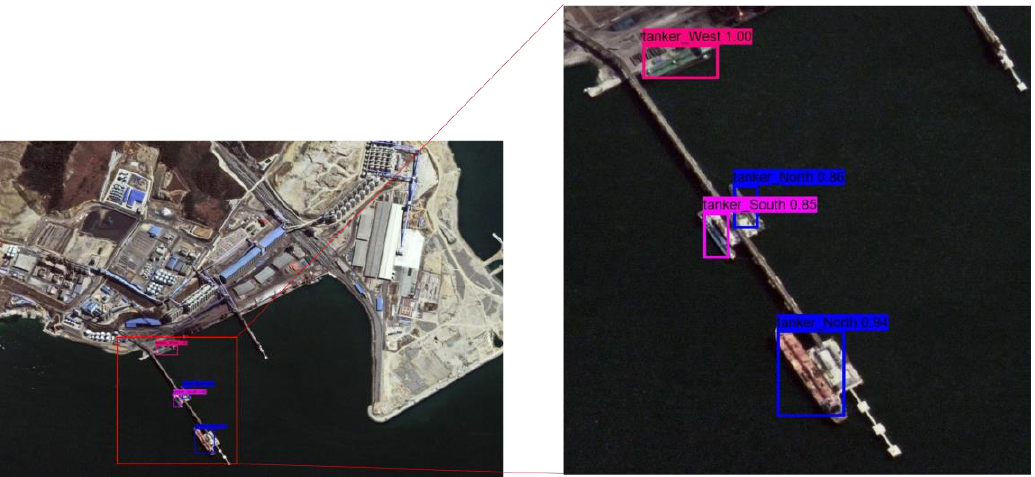
Figure 13. The QuickBird image of Pescara Port.